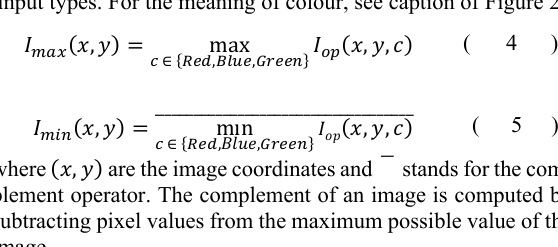
Figure 4 Saliency map comparison of the effect of the